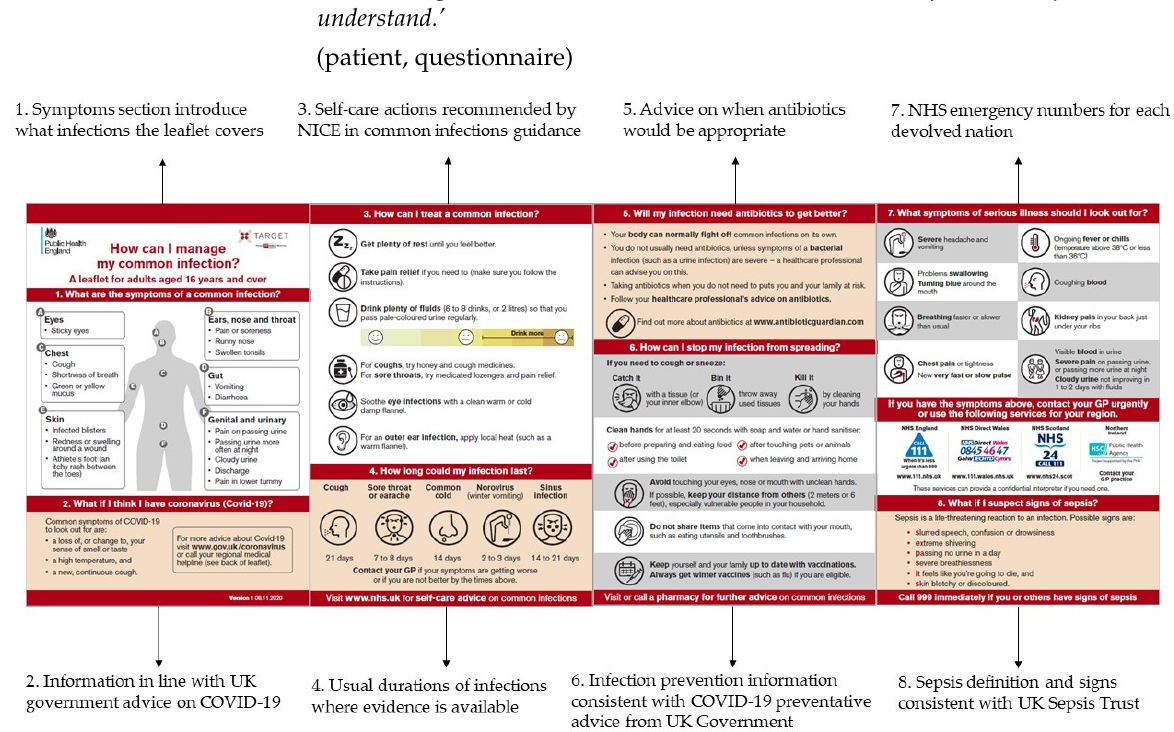
Figure 1. Labelled sections of the ‘How can I manage my common infection?’ leaflet. COVID-19—Coronavirus disease 2019. UK Government information on COVID-19 [19]. NICE—National Institute for Health and Care Excellence common infection guidance [8]. NHS—National Health Service. UK Sepsis Trust [20].